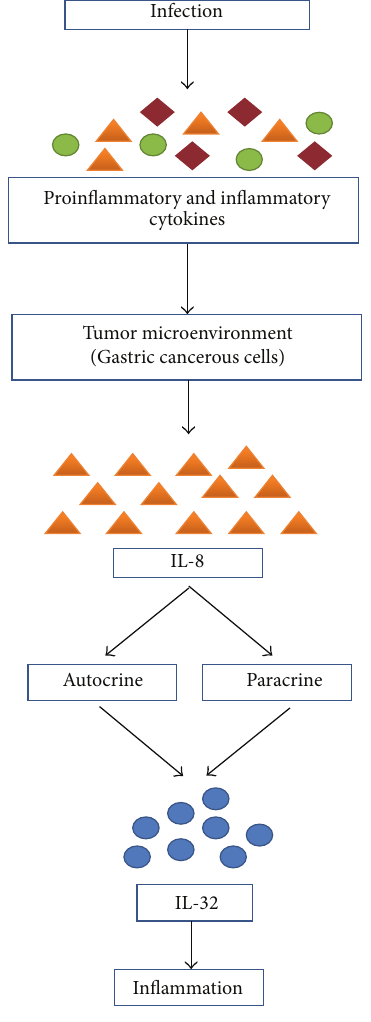
Figure 2: How gastric cancerous cells lead to inflammation medi- ated by IL-32. Infections in the body set in motion the synthesis and secretion of a variety of proinflammatory and inflammatory cytokines which results in the development of tumor microenviron- ment in gastric cancerous cells that are continuously involved in the production of IL-8 which exerts its biological influence by initiating the production of IL-32 which is blamed to be involved in gastric